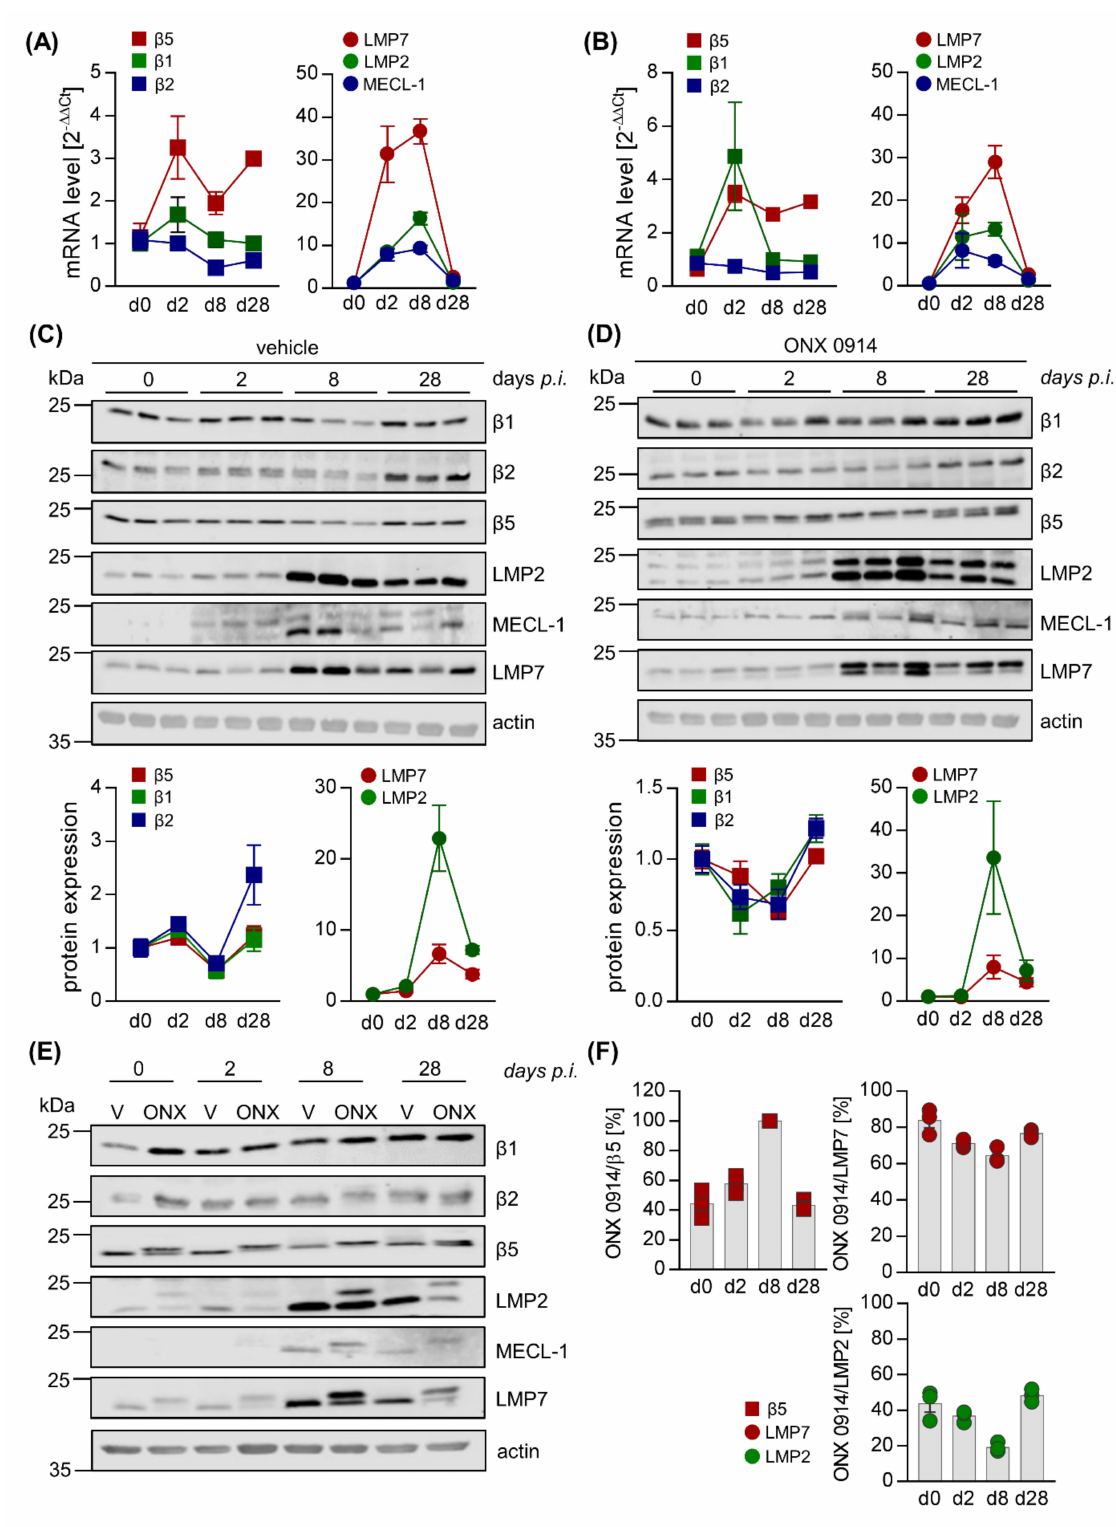
Figure 5. Loss of selectivity of ONX 0914 for the i-proteasome during acute viral myocarditis in heart tissue. Total mRNA was extracted from heart tissue of vehicle– ( A ) and ONX 0914– ( B ) treated mice sacrificed at di ff erent time points post CVB3 infection and expression levels were determined by qPCR for subunits β 5, β 1, and β 2 (standard proteasome) as well as their i-proteasome counterparts LMP7, LMP2, and MECL-1, respectively. ( C , D ) Protein homogenates were obtained and subjected to Western blot analysis, showing the protein expression of the respective subunits for three di ff erent animals